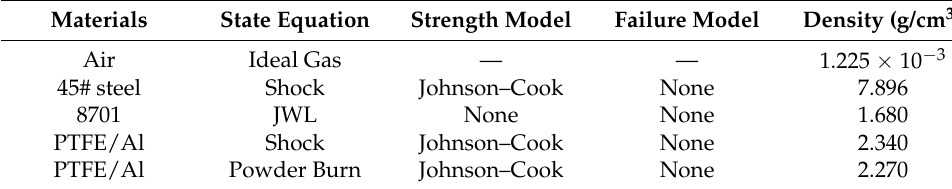
Table 1. Material parameters and state equation of the reactive liner.